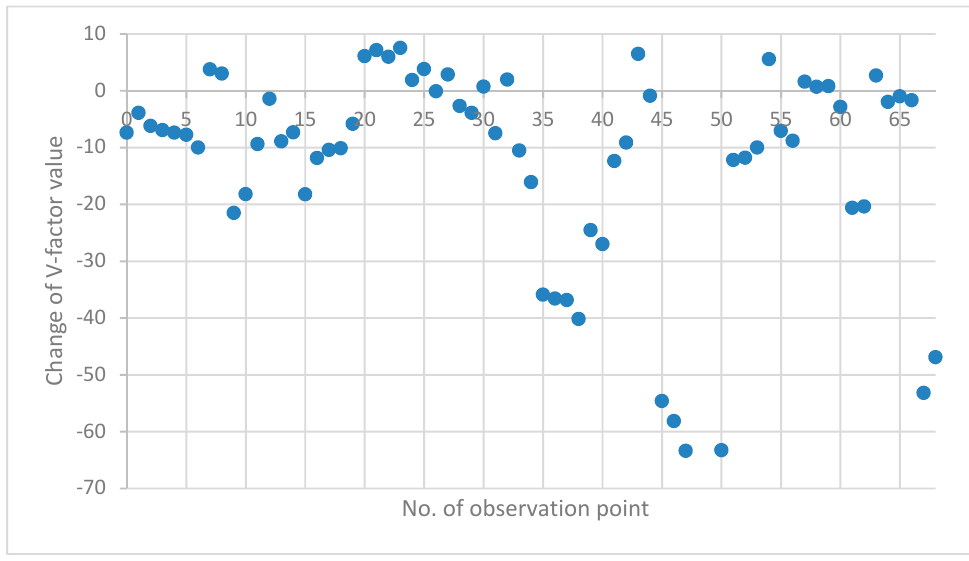
Figure 10. The change of the attractiveness of the available view for observation points as a result of the implementation of scenario 2 instead of scenario 1. Source: own work.